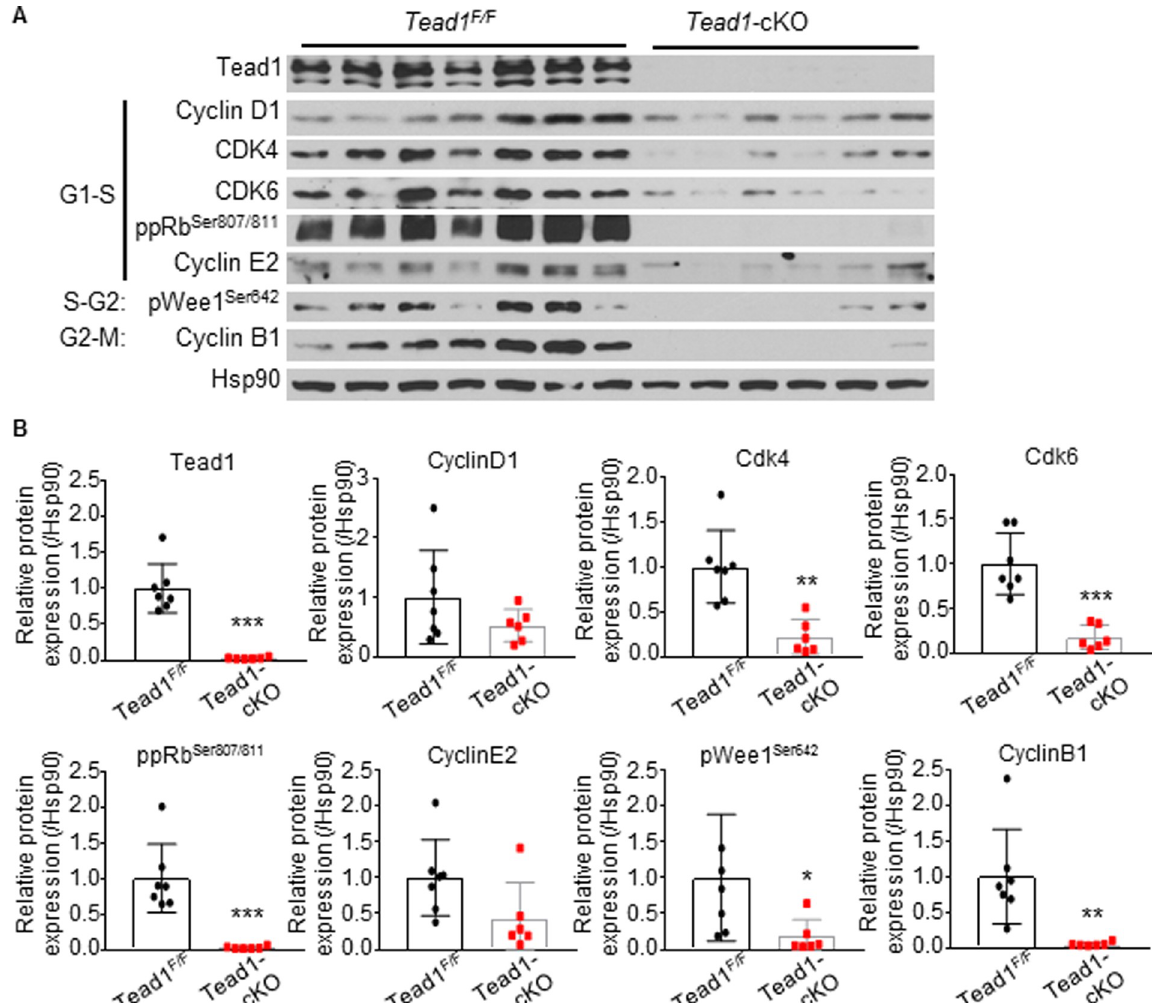
Fig 6. Loss of Tead1 leads to decreased expression of cell cycle proteins. (A) Western blot analysis of cell cycle related proteins in postnatal day 7 Tead F/F (n = 7) and Tead1 -cKO (n = 6) hearts. Loading control, Hsp90. (B) Densitometry analyses of relative protein expression, normalized by Hsp90. Data are presented as mean ± s.e.m. ��� p < 0.001, �� p < 0.01, � p < 0.05; data were analyzed by Student’s t